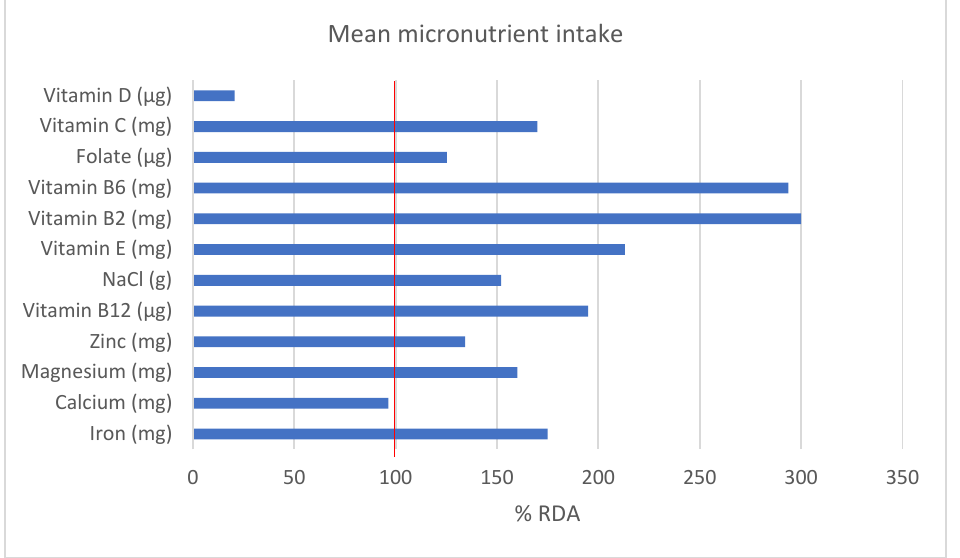
Figure 5. Intake of micronutrients among football players ( n = 23), presented as a percentage of the recommended daily intake (RDA).